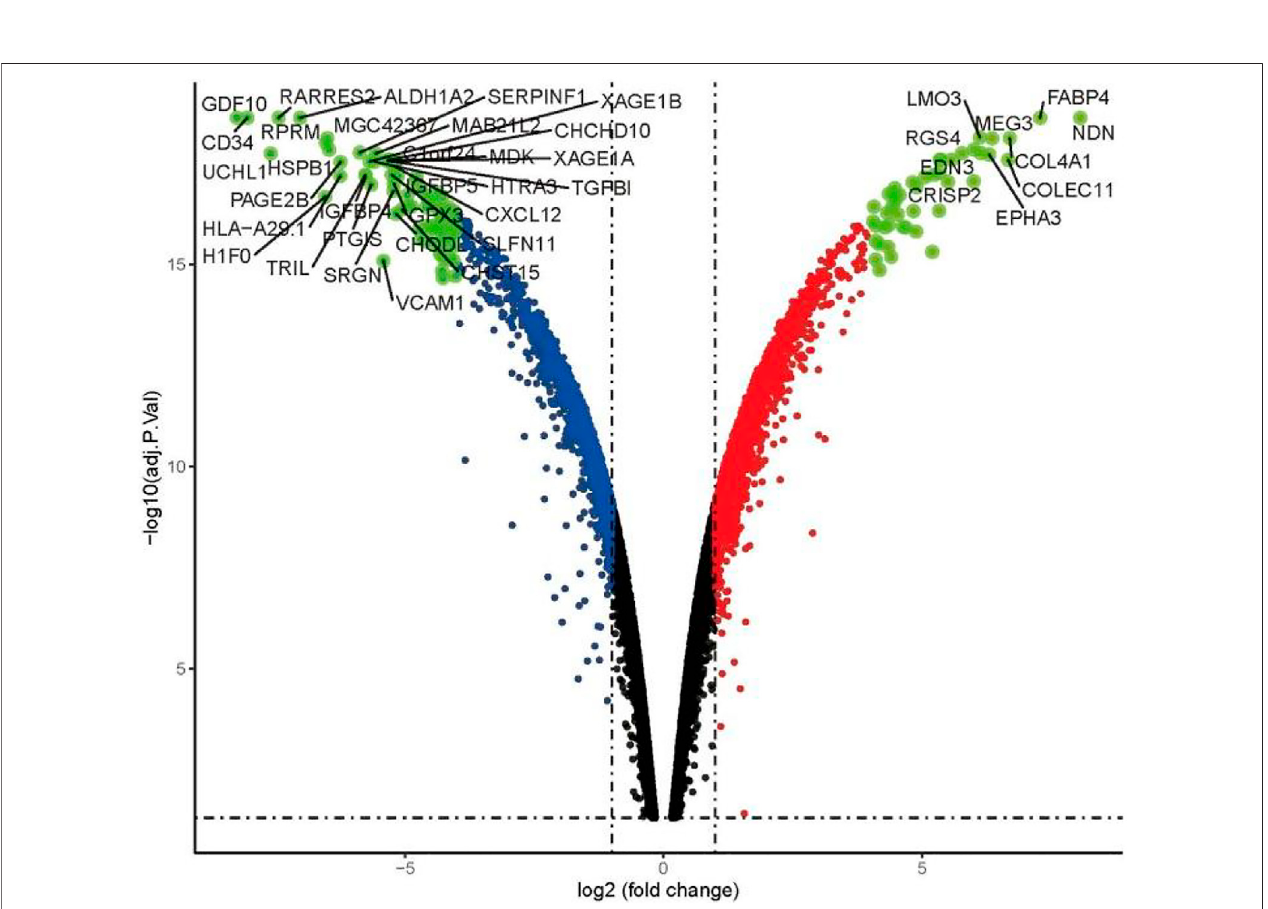
FIGURE 1 | Volcano map of differential expression analysis in GIST882 and GIST430 data